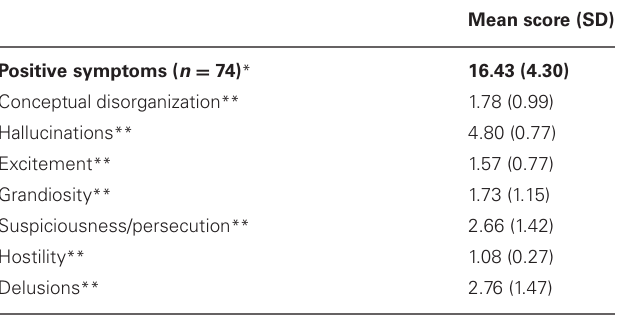
Table 1 | Mean scores for Positive symptoms (SCI-PANSS).